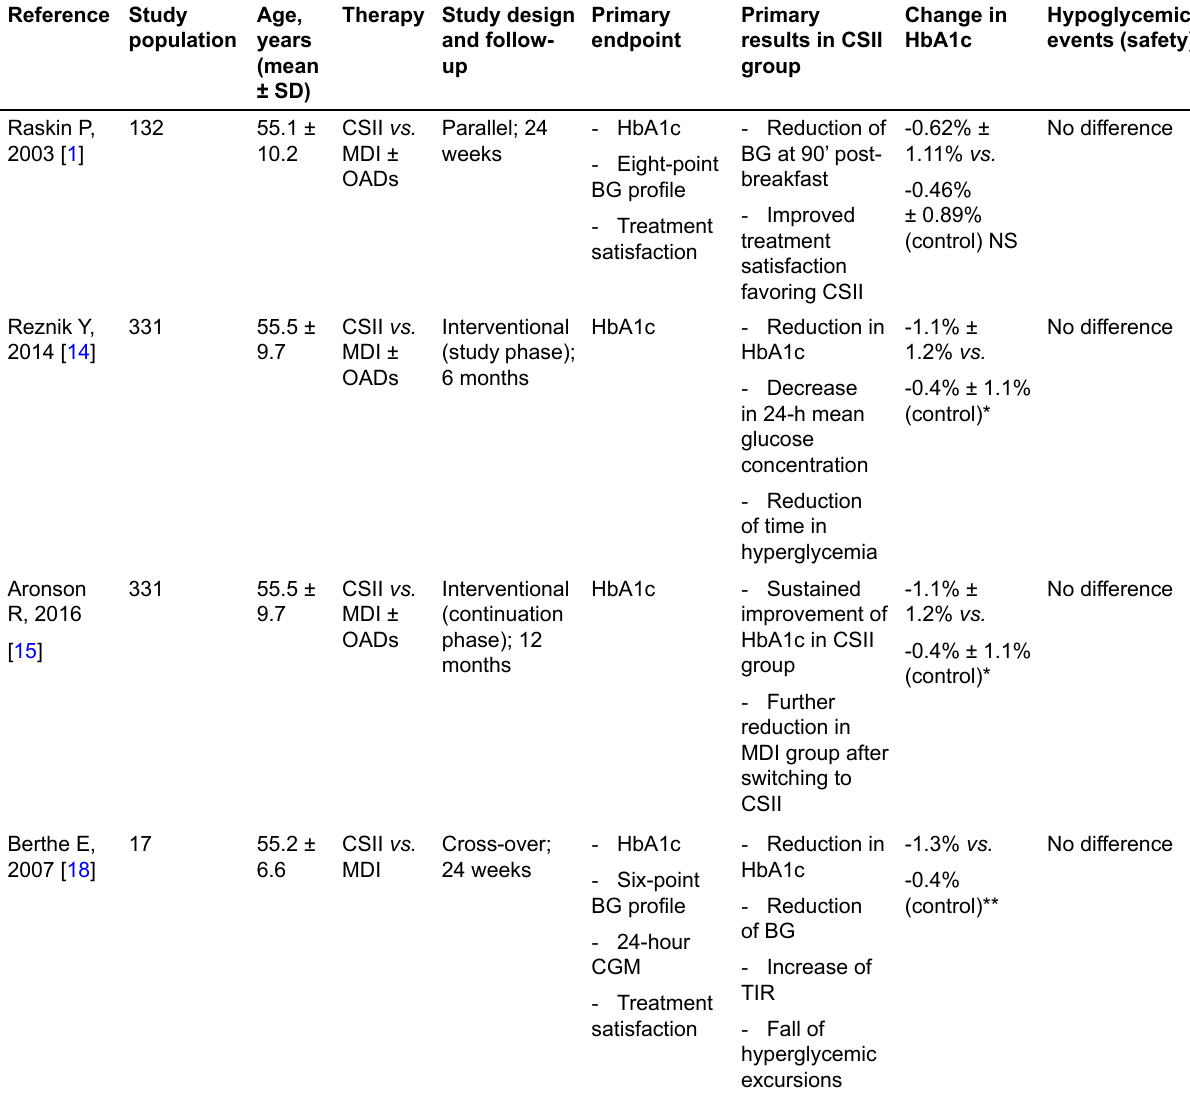
Table 1. Randomized clinical trials (RCTs) comparing CSII and MDI among people with T2D Reference